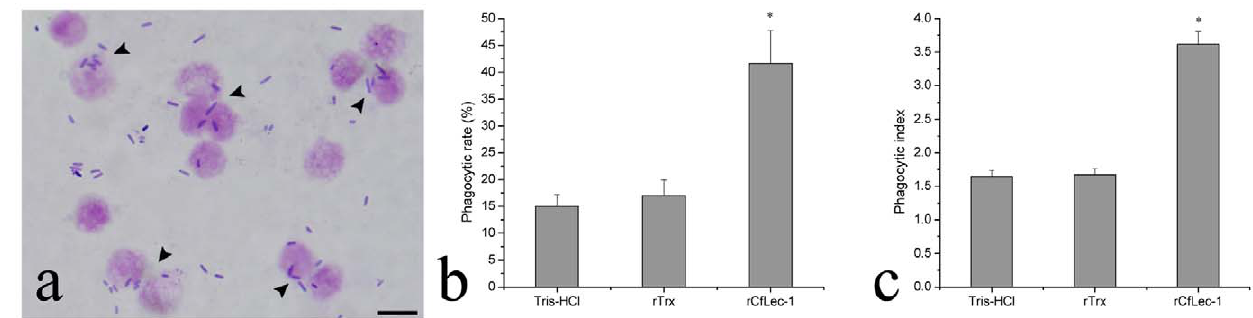
Figure 6. Phagocytosis enhanced by rCfLec-1. The hemocytes were resuspended with TBS buffer, rTrx in TBS buffer and rCfLec-1 in TBS buffer, respectively. The hemocytes were incubated for 30 min, then E. coli was added into each hemocytes suspension for another 1 h. The mixture was mounted onto a glass slide and stained with Giemsa. The phagocytic activity of hemocyte was measured using a light microscope. Two hundred hemocytes on each slide were counted. Phagocytic rate (PR) = (phagocytic hemocytes)/(total hemocytes) 6 100%; phagocytic index (PI) =average number of bacteria in phagocytic hemocytes. For each treatment, assay was performed in three different slides for statistic analysis.